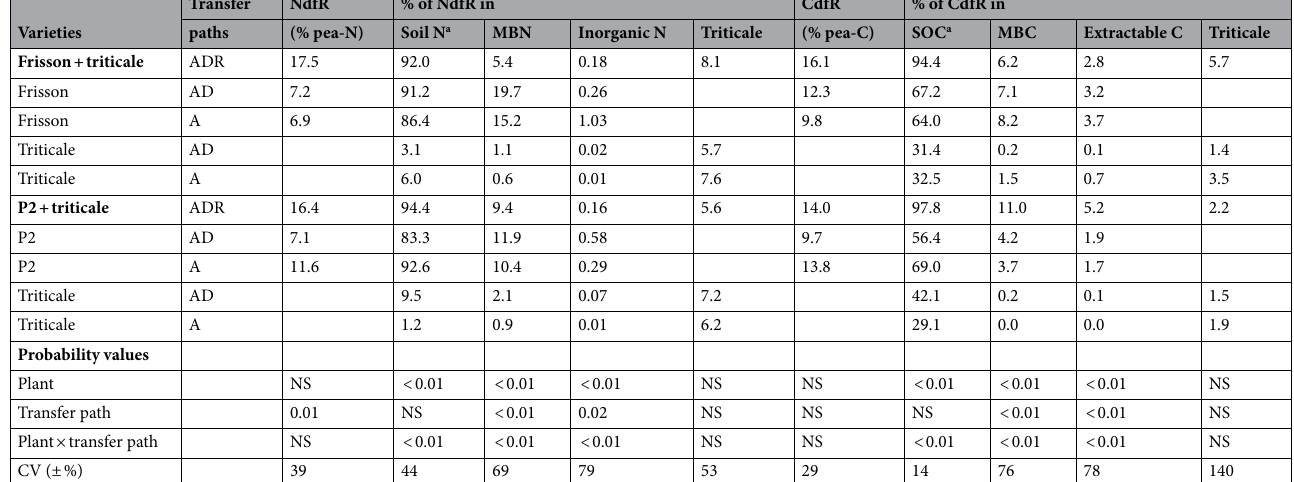
Table 6. Relative distribution of N and C derived from pea rhizodeposition in soil and triticale at the end of a 105-day greenhouse pot experiment; transfer paths: ADR = AMF, diffusion, and root contact between pea and intercrop; AD = AMF and diffusion; A = only AMF; CV = mean coefficient of variation between replicate pots (n = 6); probability values of a two-way ANOVA, using pea variety and transfer path treatment as factors, NS = not significant. a Including MBN and 0.5 K 2 SO 4 extractable inorganic N or MBC and 0.5 K 2 SO 4 extractable organic C from non-fumigated